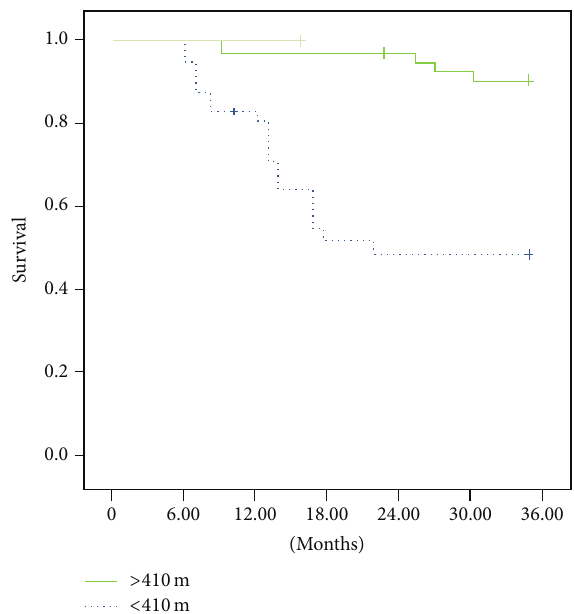
Figure 1: The patients who covered a 6MWT distance shorter than 410 m had a survival rate of 55% compared with a rate of 97% for those who walked more than 410m ( 𝑝 = 0.0001 ). Relative risk = 4.21 (1.25–6.41, 95% CI). of 0.87, a sensitivity of 92%, and a specificity of 31%. The VO 2 peak area under the curve was 0.78, with a sensitivity of 87% and a specificity of 41%. MIP had an area under the ROC curve of 0.69, with a sensitivity of 71% and a specificity of